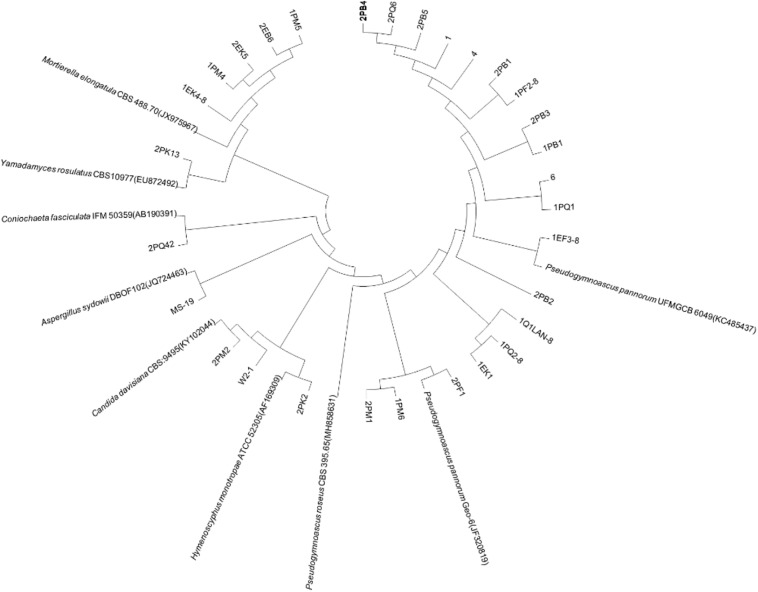
Antarctica fungus phylogenetic trees based on ITS sequences.